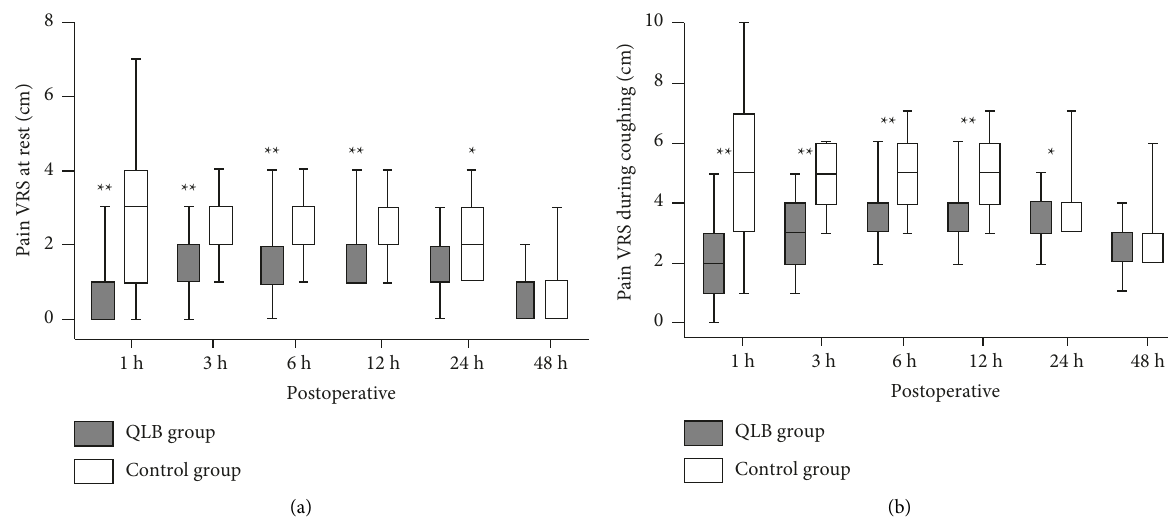
Figure 2: Pain at rest and during coughing at 48h after surgery: (a) VRS at rest and (b) NRS during coughing. Data are presented as median and interquartile range at rest or during coughing. The VRS scores were significantly lower at 1, 3, 6, 12, and 24h after surgery in the QLB group than that in the control group. ∗ P < 0 . 05 and ∗∗ P < 0 . 001. QLB: quadratus lumborum block.